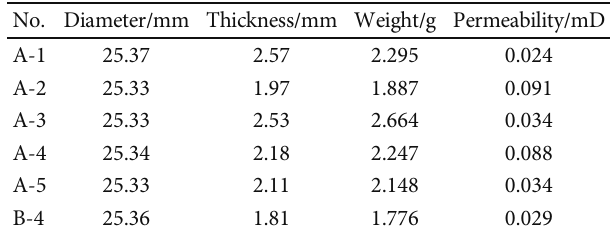
Table 1: List of core slice parameters.